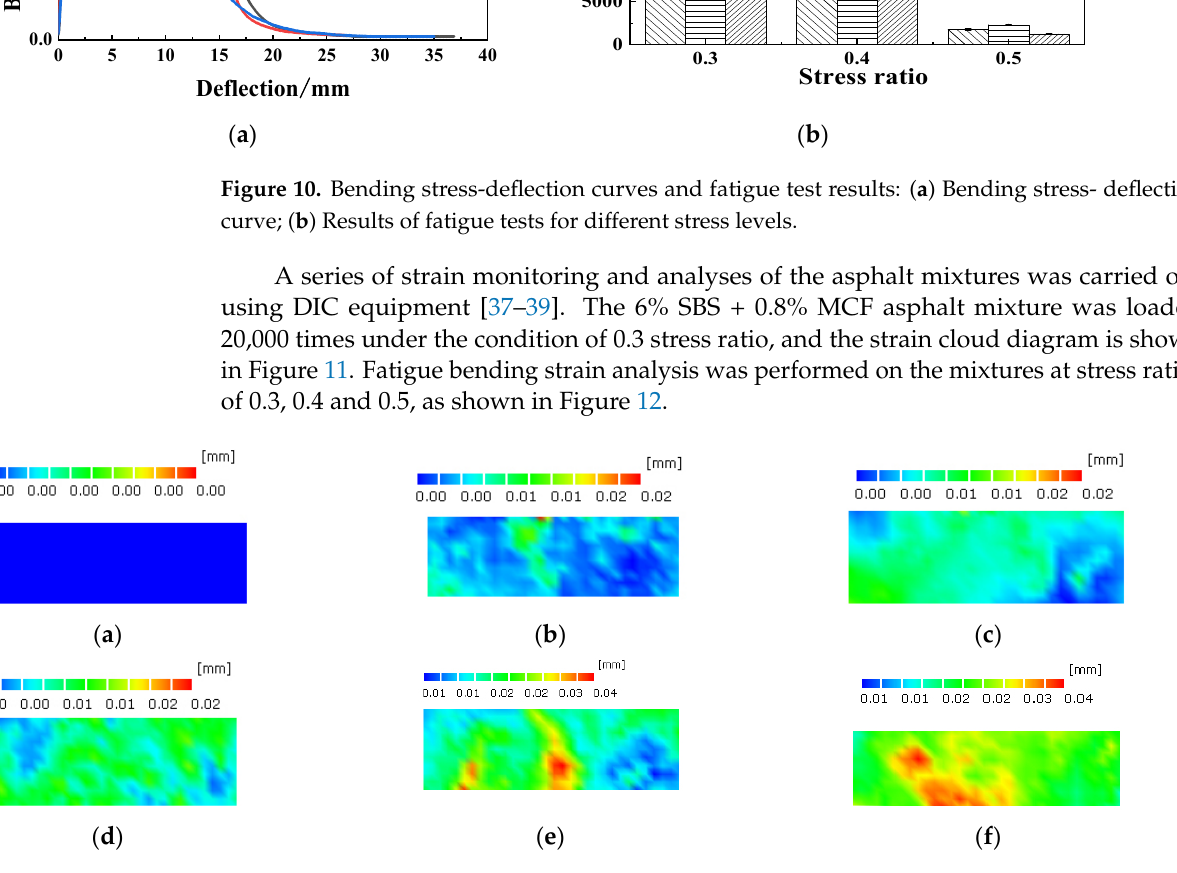
Figure 11. Strain cloud diagram of 6% SBS + 0.8% MCF asphalt mixture under different loading times in fatigue test. ( a ) loaded 0 times; ( b ) loaded 4000 times; ( c ) loaded 8000 times; ( d ) loaded 12,000 times; ( e ) loaded 16,000 times; ( f ) loaded 20,000